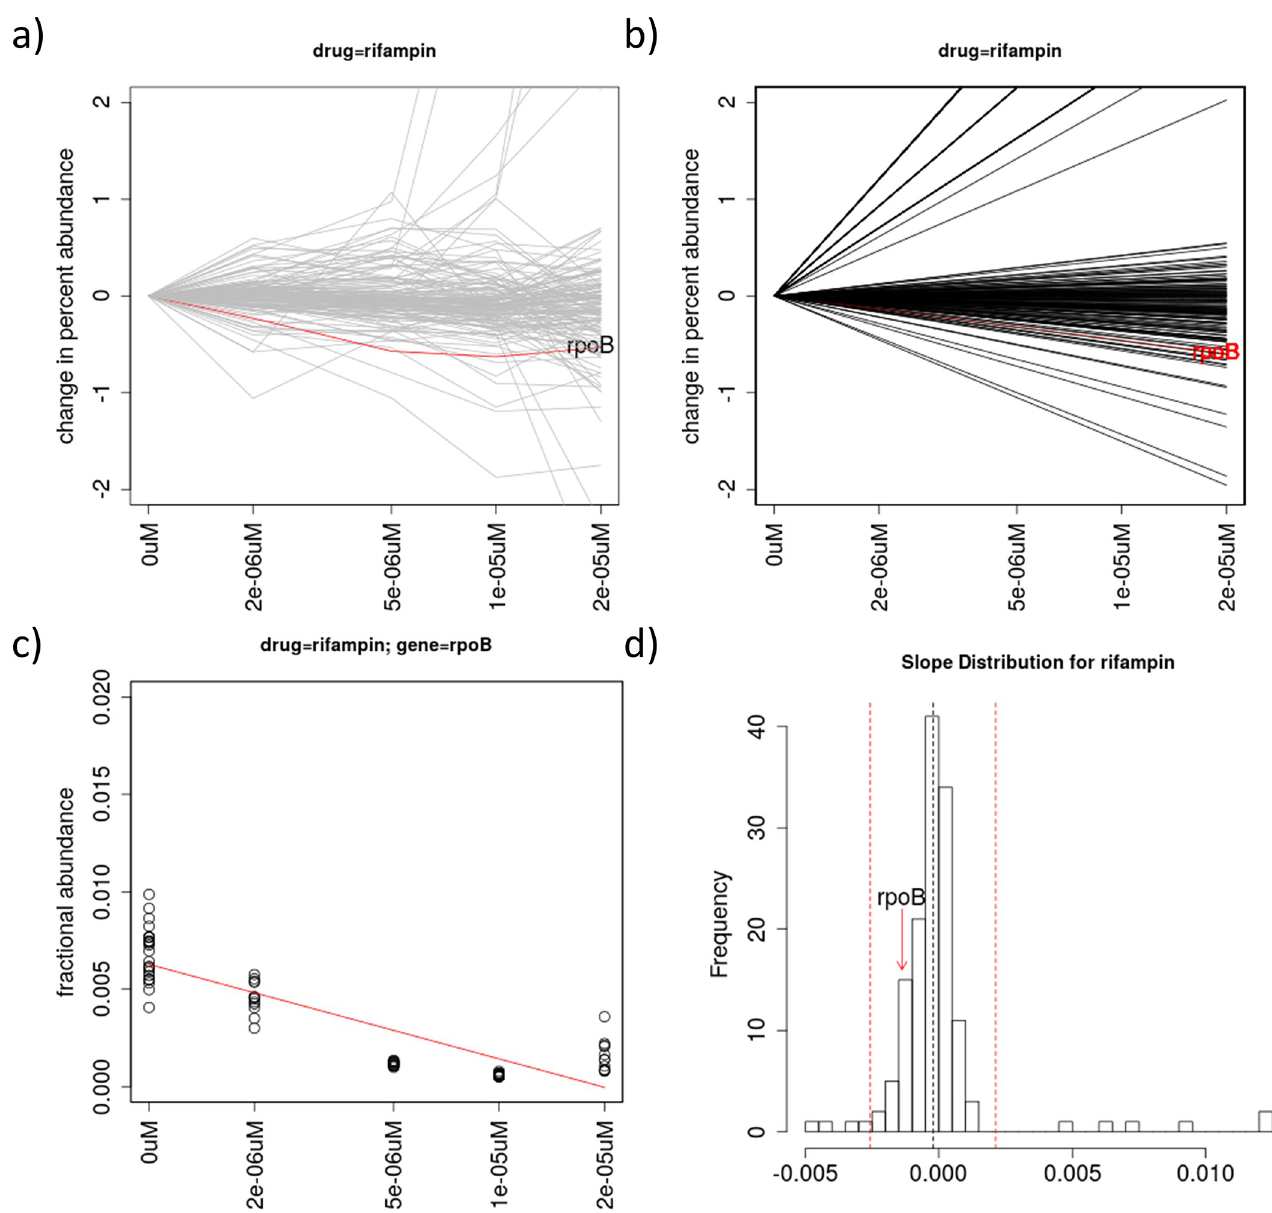
Fig 2. Analysis of data for treatment of an M . tuberculosis hypomorph library with rifampin. (a) Plot of relative abundances of knock-down mutants for all 162 genes in the library, with the known interacting gene rpoB highlighted in red, showing depletion. The Y-axis represents the change in percent abundance of each gene, as in Fig 1. (b) Plot of regression lines for all the genes based on slopes as random-effect coefficients in the linear mixed-model. (c) Plot of relative abundance data points and regression line fit specifically for rpoB . (d) Histogram of the slope coefficients for all genes in the library, with rpoB highlighted (with negative slope, but not an outlier). The dashed red lines indicate the outlier cutoffs defined by Zrobust = ± 3.5.